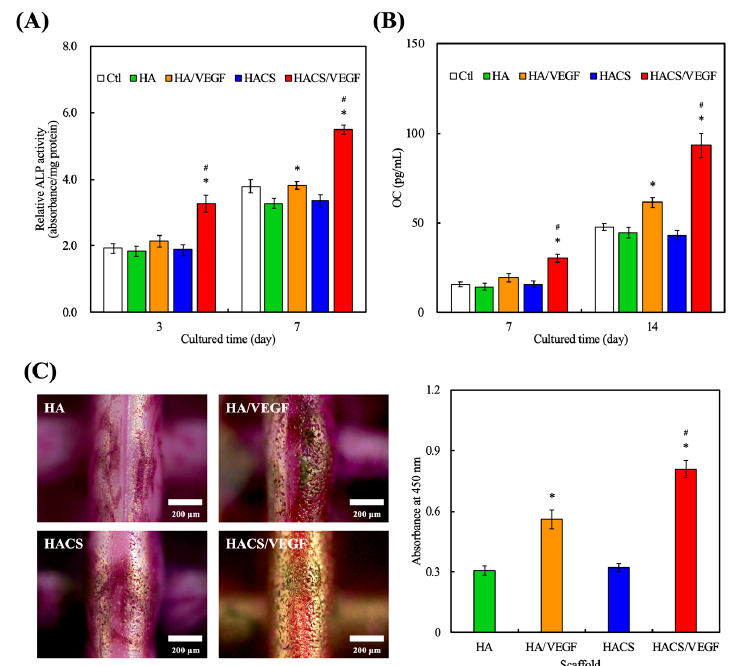
Figure 8. ( A ) The ALP and ( B ) OC protein expression levels of hMSCs cultured on various scaffolds for various time-points. ( C ) Alizarin red S staining and quantification of Ca mineral deposits after culture for 14 days. Data are presented as mean ± SEM, n = 3 for each group. “*” indicates a significant difference ( p < 0.05) when compared to the scaffold without VEGF. “#” indicates a significant difference ( p < 0.05) when compared to HA/VEGF.